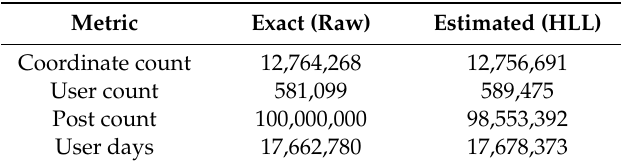
Table 1. Total counts for di ff erent metrics based on raw and HLL data with default parameters (to reproduce these numbers, see Supplementary Materials,